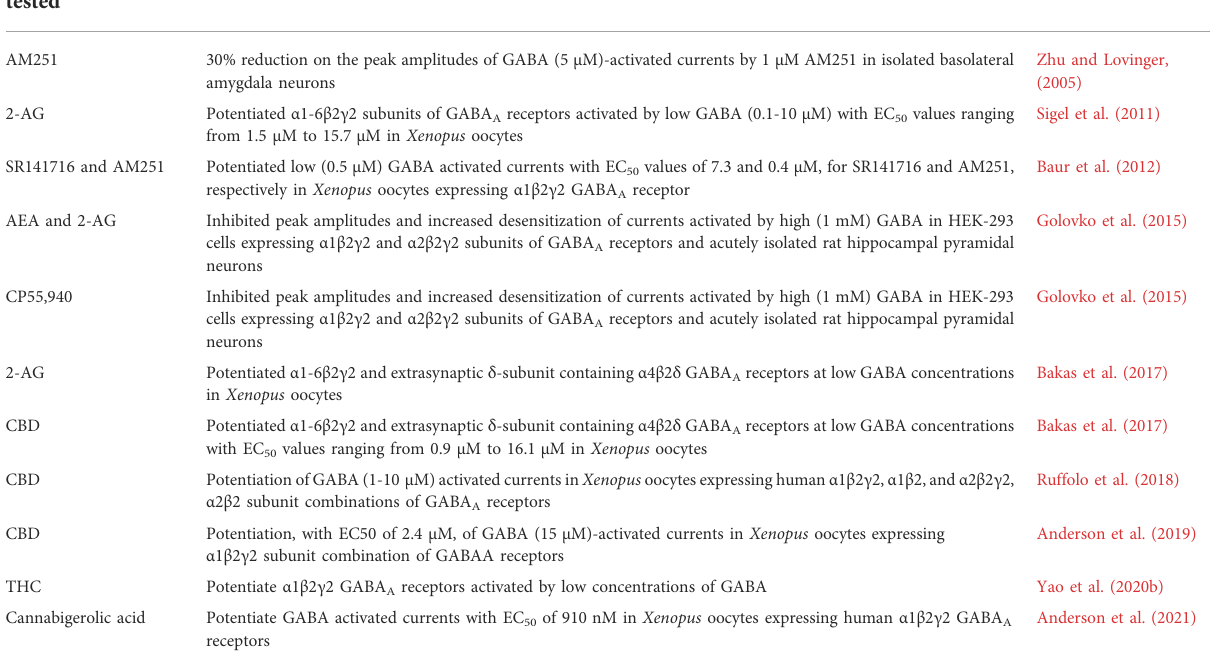
TABLE 4 Effects of cannabinoids on GABA A receptors. Cannabinoid